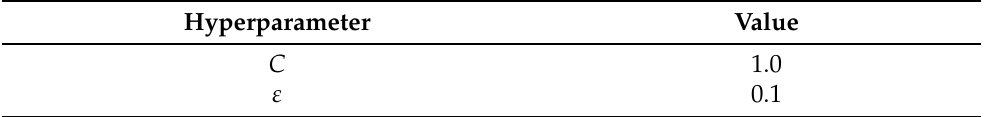
Table 2. SVR-based multi-output regressor